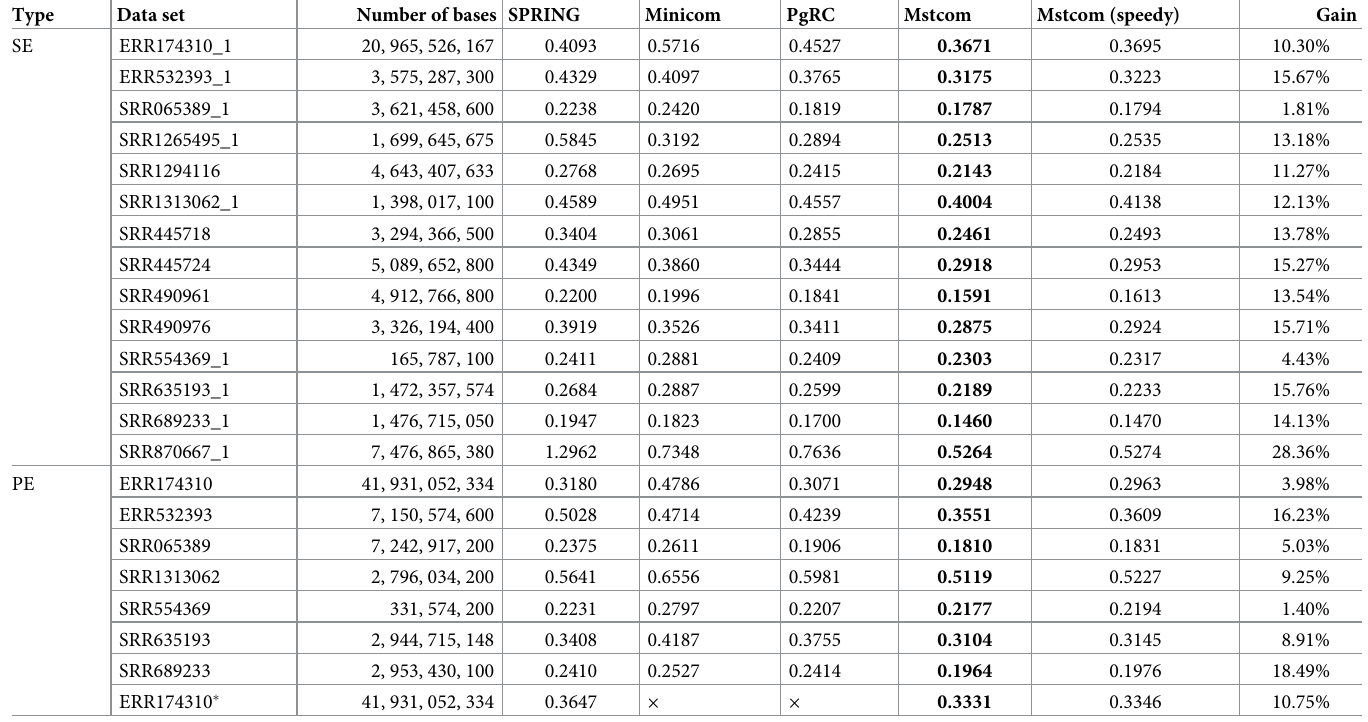
Table 1. Compression ratios by different methods under the order-free mode.